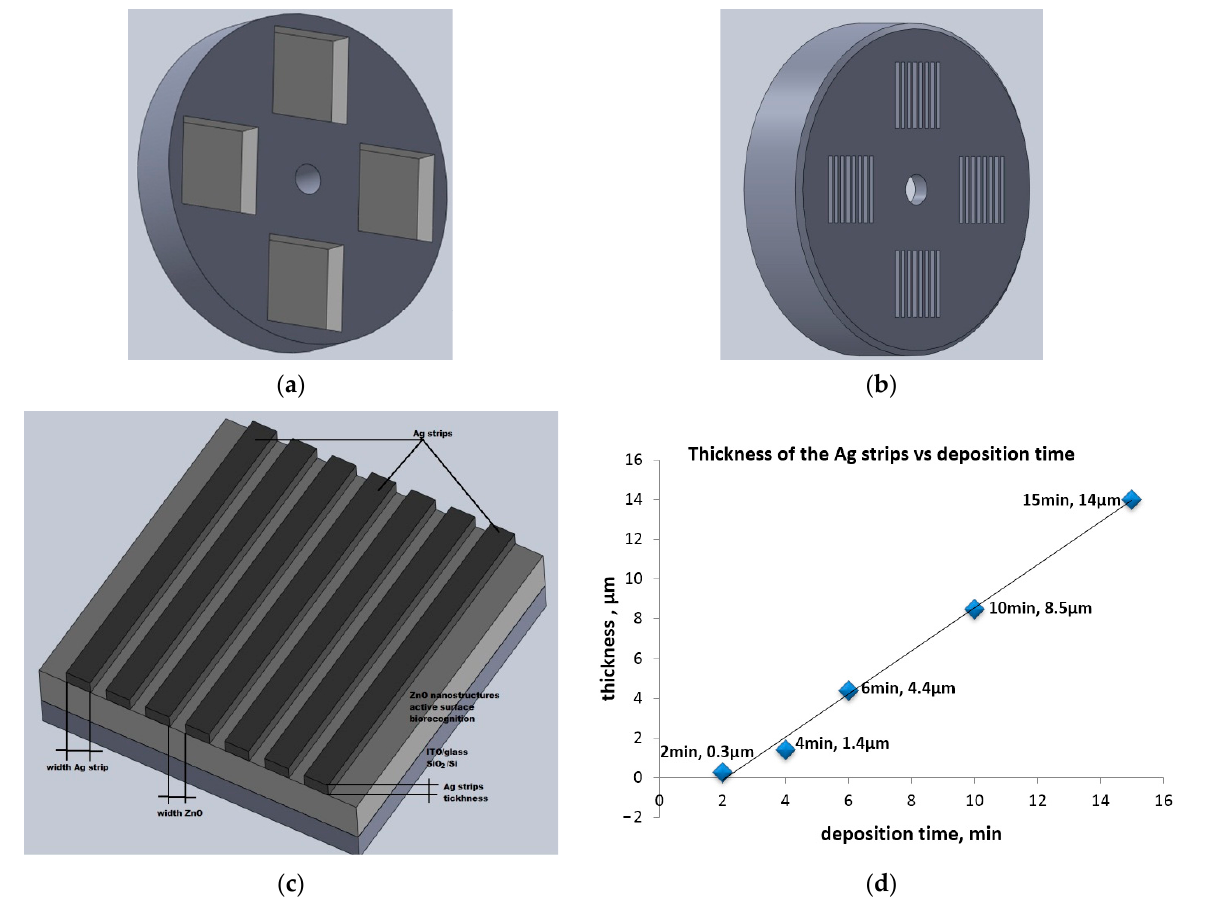
Figure 2. ( a ) Mask for Zn deposition; ( b ) mask for Ag strip deposition; ( c ) metallic structure type MSG; and ( d ) thickness vs. time.